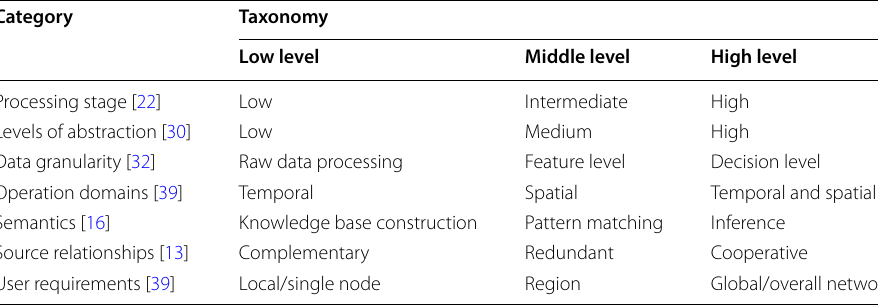
Table 2 Data fusion taxonomy